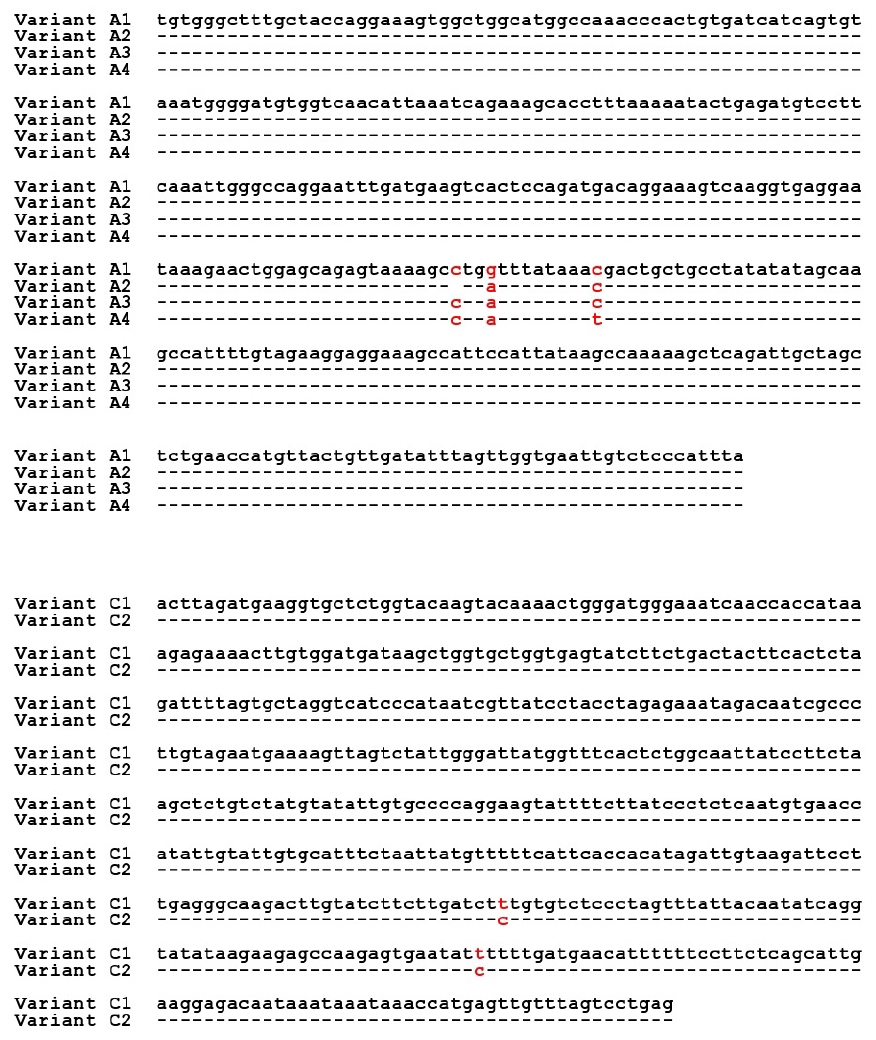
Figure 2. Sequences of the detected variants in Region 1 ( A1, A2, A3 , and A4 ) and Region 2 ( C1 and C2 ) of the FABP4 gene in Sfakia